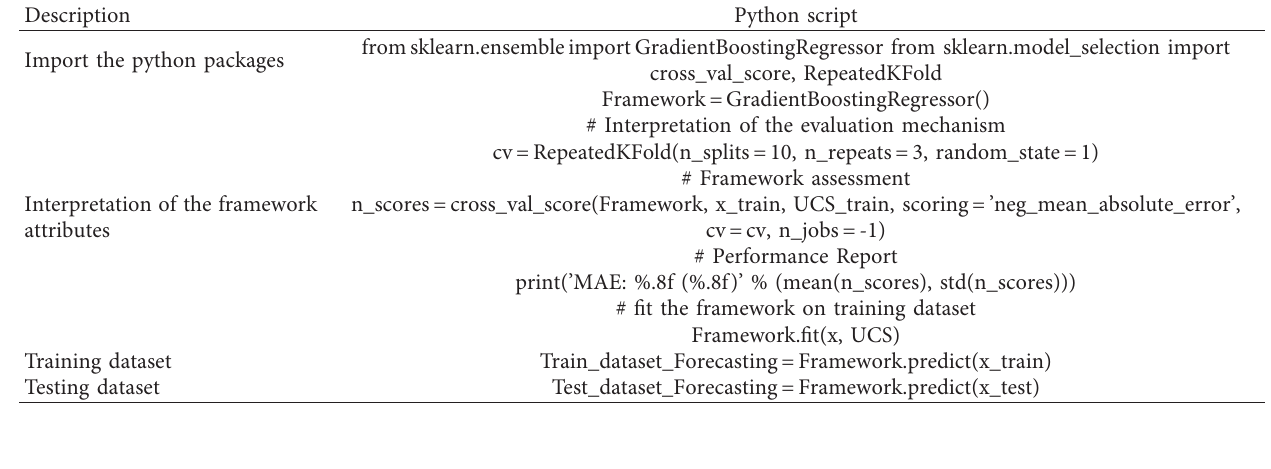
Table 4: Executing a GBR framework in python employing the gradient boost